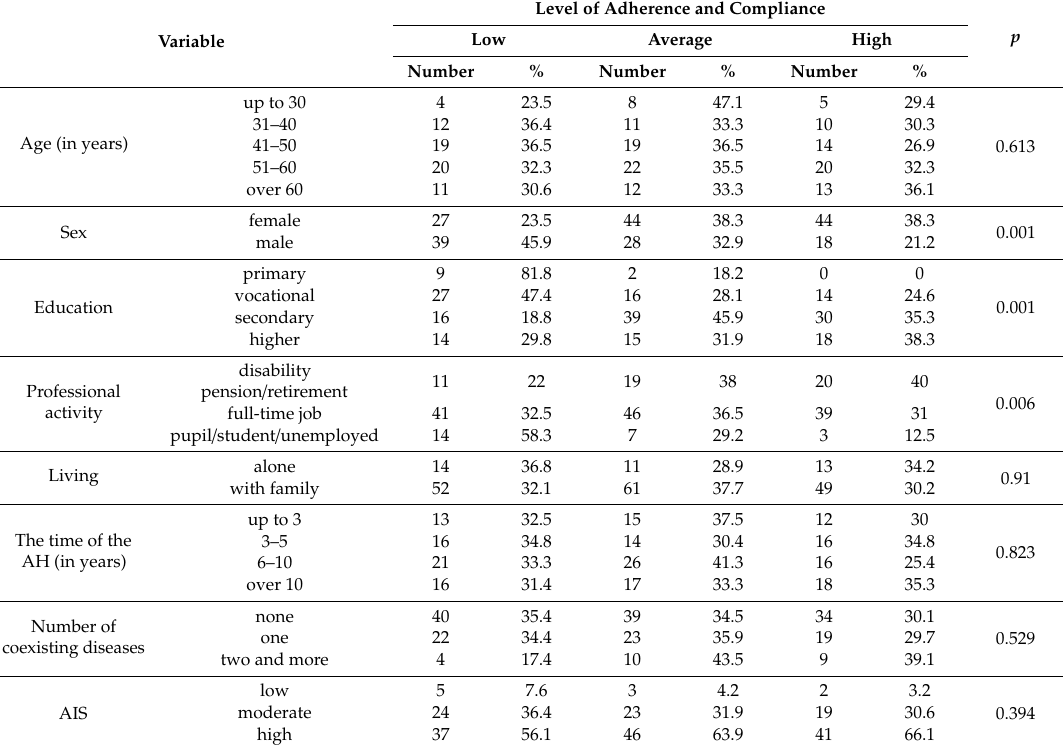
Table 6. Detailed set of adherence and compliance results